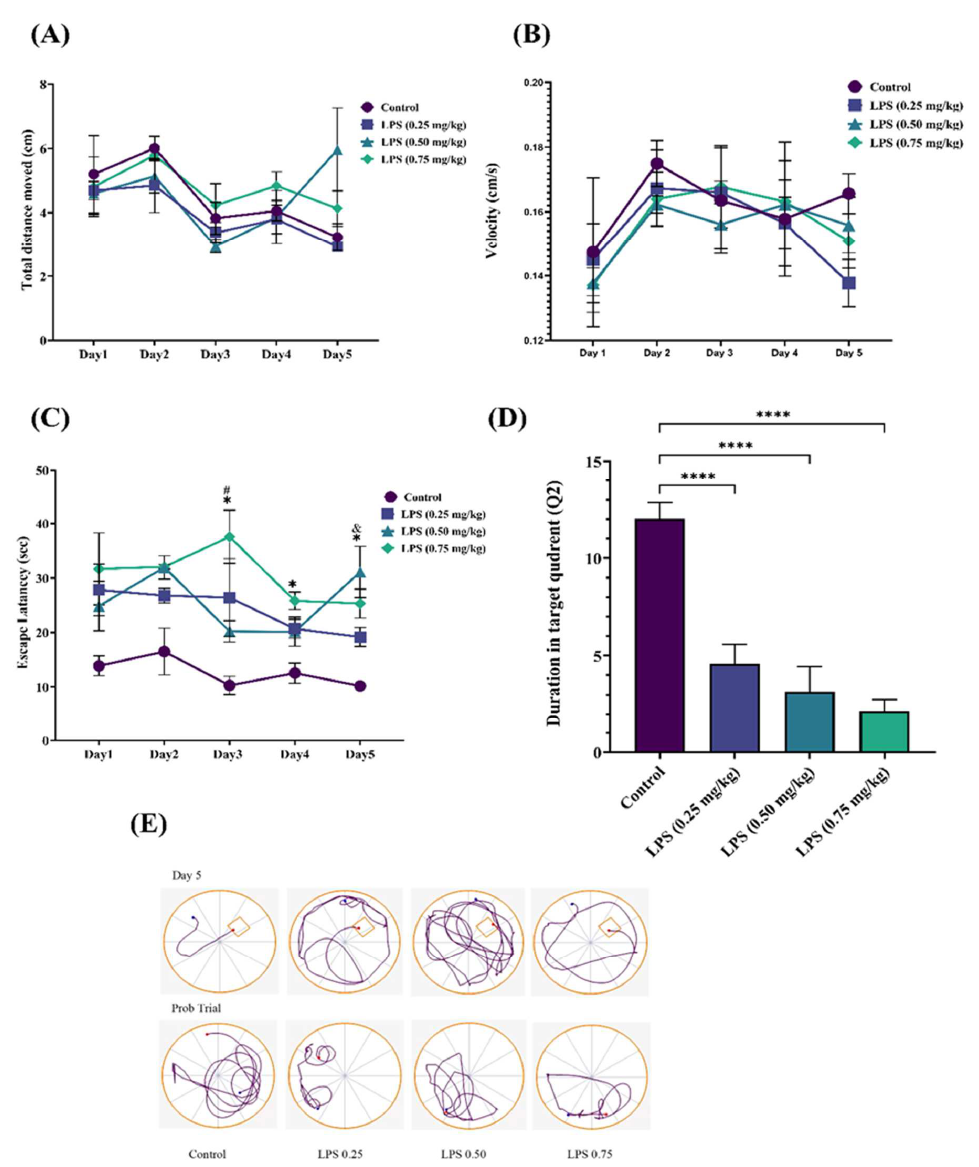
Figure 3. Morris water maze. ( A ) Total distance moved; no significant differences were observed in the total distance moved among all groups. ( B ) Velocity; no significant differences were observed in swimming velocity among all groups. ( C ) Escape latency; no significant difference was observed in the escape latency time among all groups in the first two days. The 0.75 mg/kg LPS group showed a significant increase in escape latency time in the 3 remaining days, while the 0.50 mg/kg and 0.25 mg/kg LPS groups exhibited significantly increased escape latency time only on days 3 and 5, respectively. ( D ) Probe test; the LPS groups spent significantly less time in the target quadrant than the control group. ( E ) Representative tracking plot of days 5 and 6. Data are presented as the mean ± SEM. (A–C) Two-way ANOVA was used followed by a post hoc Dunnett’s test. ( D ) One-way ANOVA was used followed by a post hoc Dunnett’s test. LPS: lipopolysaccharide; sec: seconds; SEM: standard error of the mean; ANOVA: analysis of variance. $ p < 0.05, 0.25 mg/kg LPS group, # p < 0.05, & p < 0.05, 0.50 mg/kg LPS group, and * p < 0.05, 0.75 mg/kg LPS group compared with the control group, **** p <